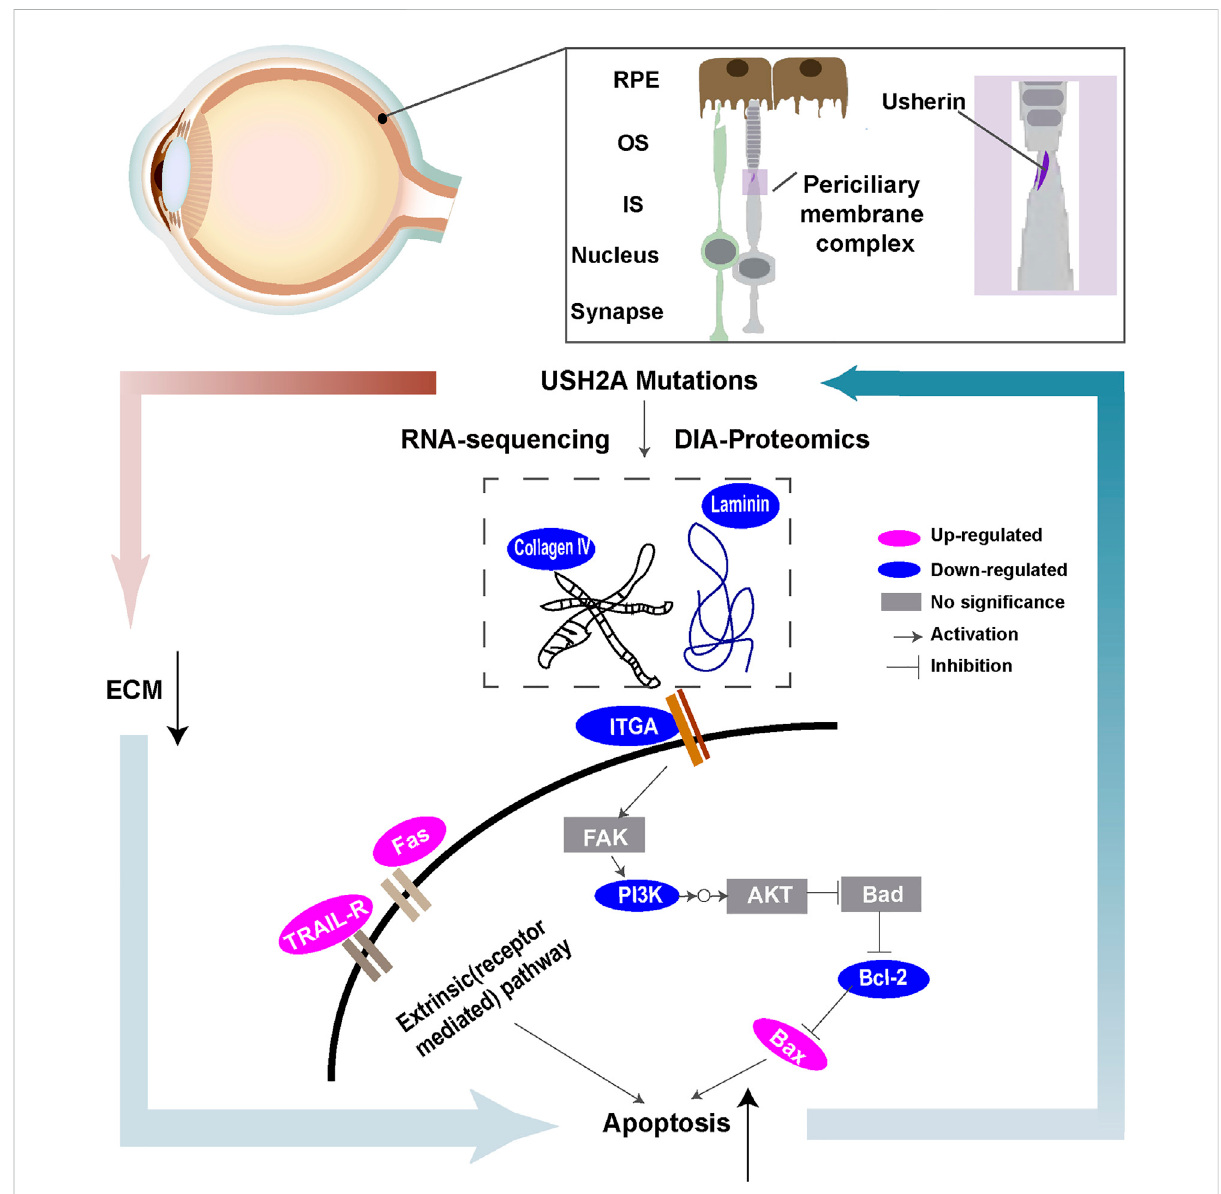
FIGURE 8 Schematic overview of ECM-receptor interactions of molecules with special emphasis on signaling pathways based on transcriptional and proteomic pro fi les.